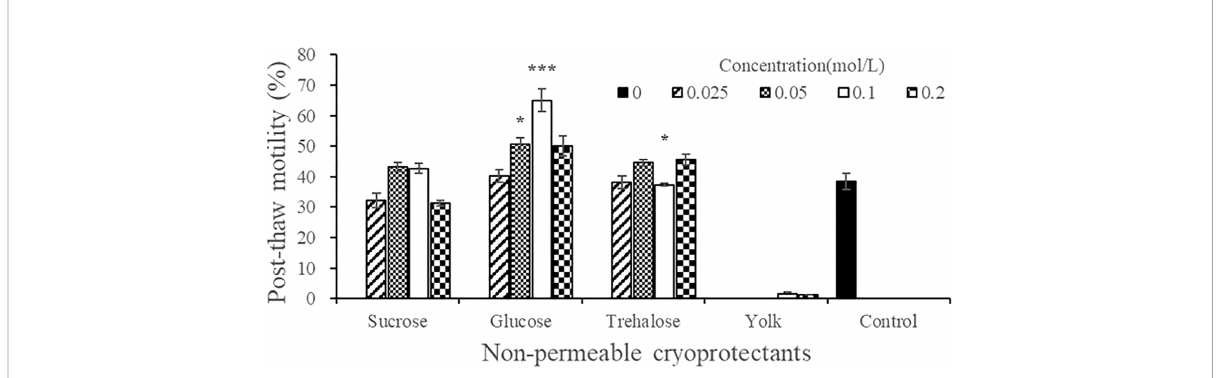
FIGURE 6 Effect of the types and concentrations of four non-permeable cryoprotectant agents on the post-thaw motility of A. japonicus spermatozoa. Note: The egg yolk powder uses the mass concentration (W/V), 0.1 represents 10% (0.1 kg/L), and 0.2 represents 20% (0.2 kg/L). Data are presented as the means ± SE (n = 4). Asterisks indicate signi fi cant differences between each experimental group and the control group (*P < 0.05, ***P < 0.001). One-way ANOVA was performed between the four concentration treatment groups of the three carbohydrates and the control group respectively, and data were not transformed.